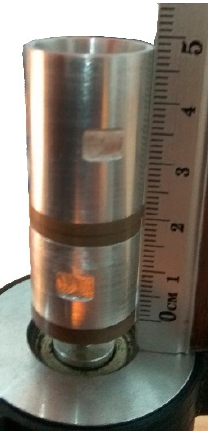
Figure 7. Prototype of the traveling wave actuator.